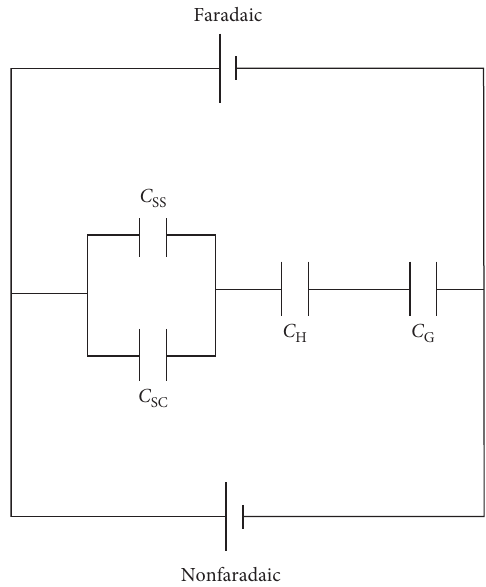
Figure 1: Schematic of the model that represents the potential difference across the electrolytic bulk for ideal MO x